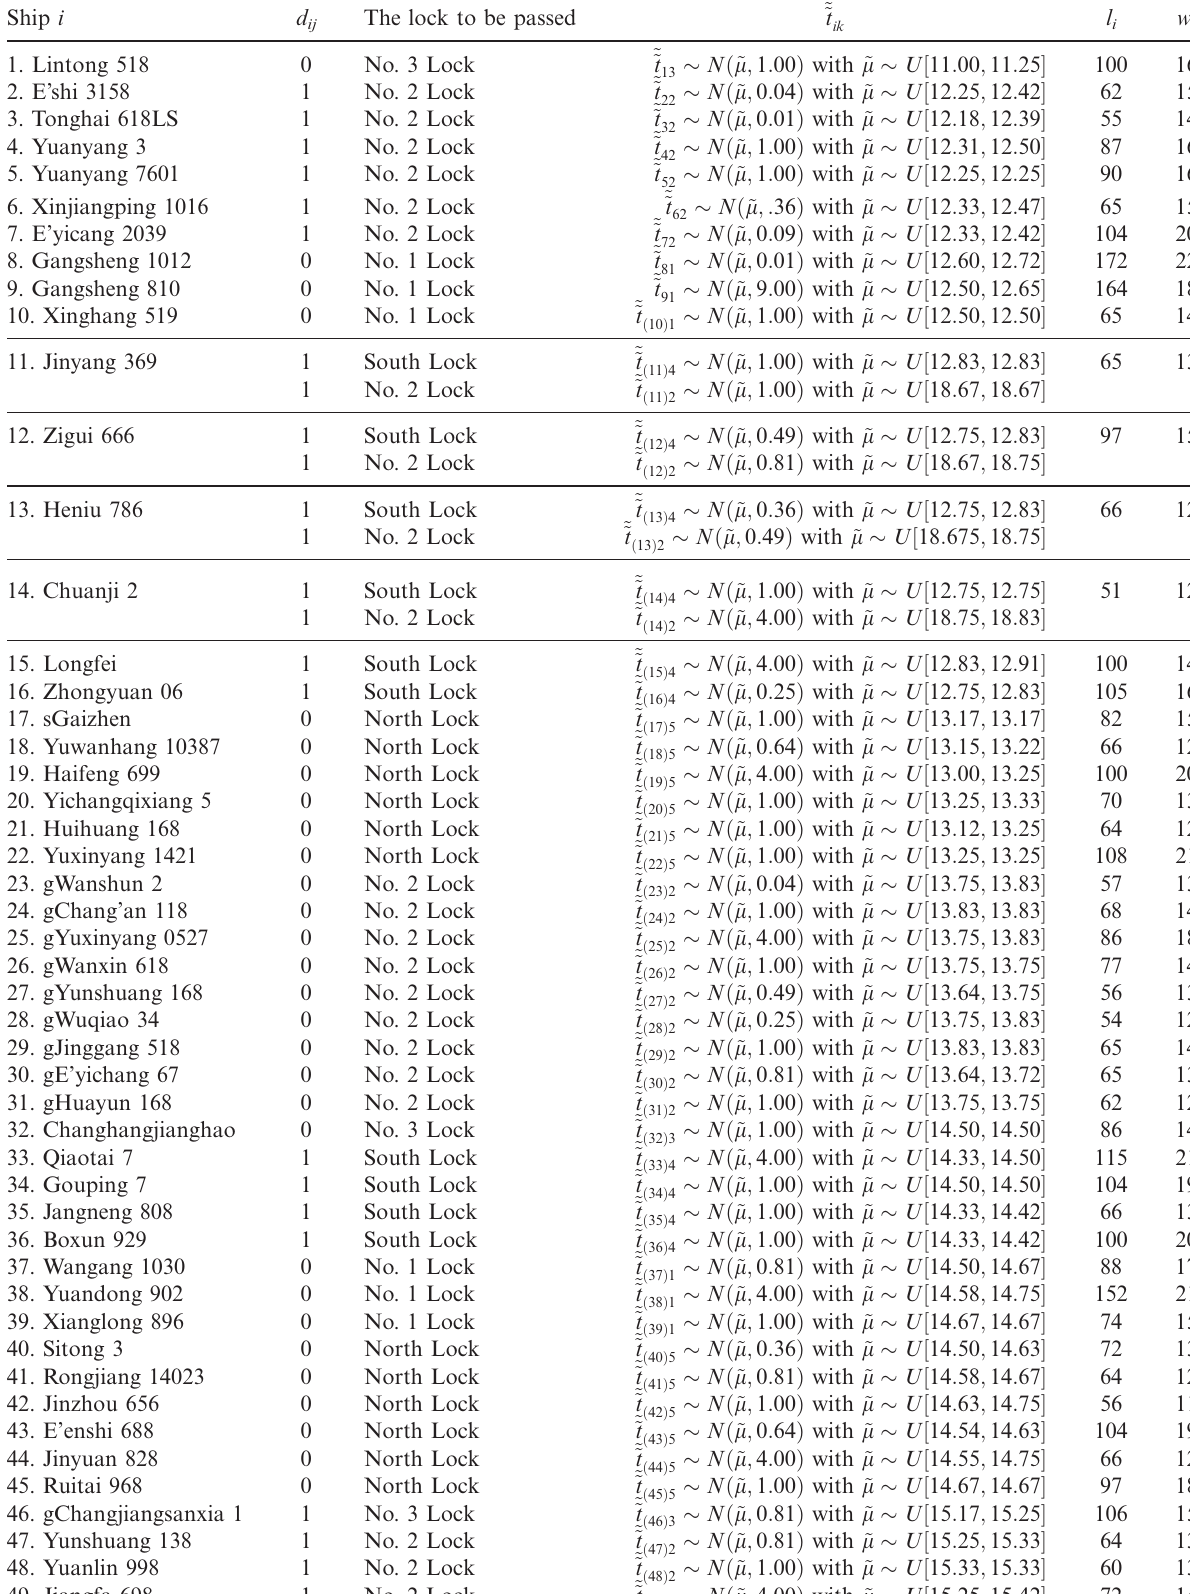
Table 2. The related data of navigation